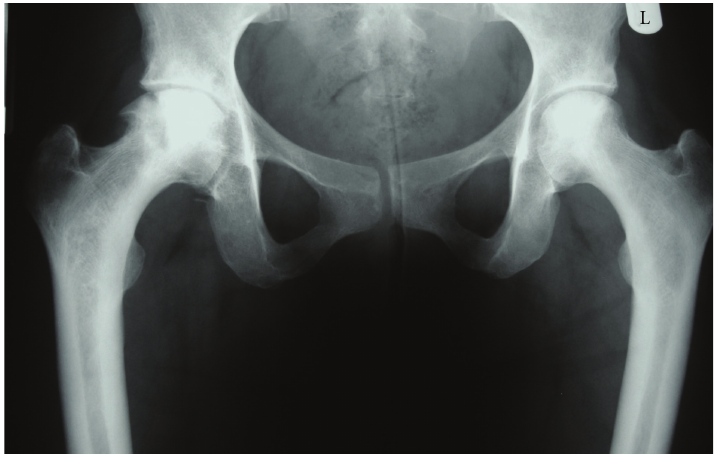
Figure 8: Plain radiograph of the pelvis in another patient with sickle cell anaemia more advanced avascular necrosis with sclerosis and subchondral collapse of the right femoral head. Less severe changes are seen on the